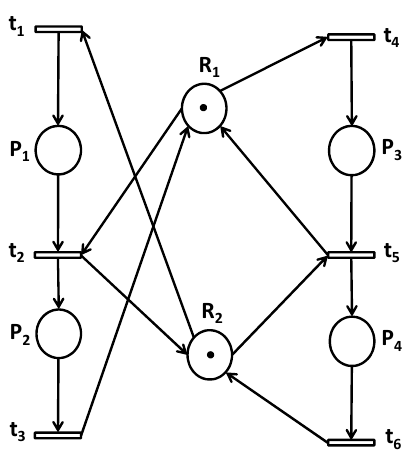
Figure 4. PN model with shared resources.